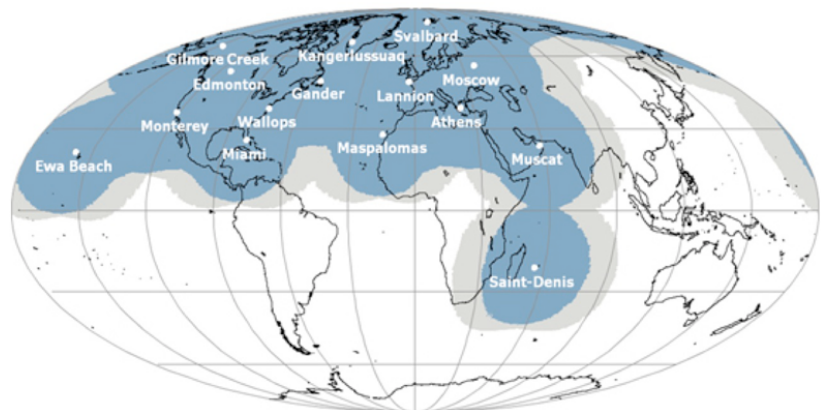
Fig. 8. Map of EUMETSAT Advanced Retransmission System (EARS) stations that receive AMSU/MHS data directly from the over- passing NOAA and MetOp satellites, and retransmit the data to EUMETSAT Headquarters. The color coding indicates the percentage of the actual satellite passes over a given geographical region – i.e., swaths that can be received by the proposed station network. Light grey corresponds to 0–50% and blue corresponds to 50–100% (here, 100% indicates that every time the region is in the field of view of the instrument, then the image data will be received by the network, while 50% indicates that, on average, every second pass cov- ering the region will be received). (Courtesy of EUMETSAT: http://www.eumetsat.int/website/home/Satellites/CurrentSatellites/Metop/ RegionalDataService/EARSATOVS/index.html.)